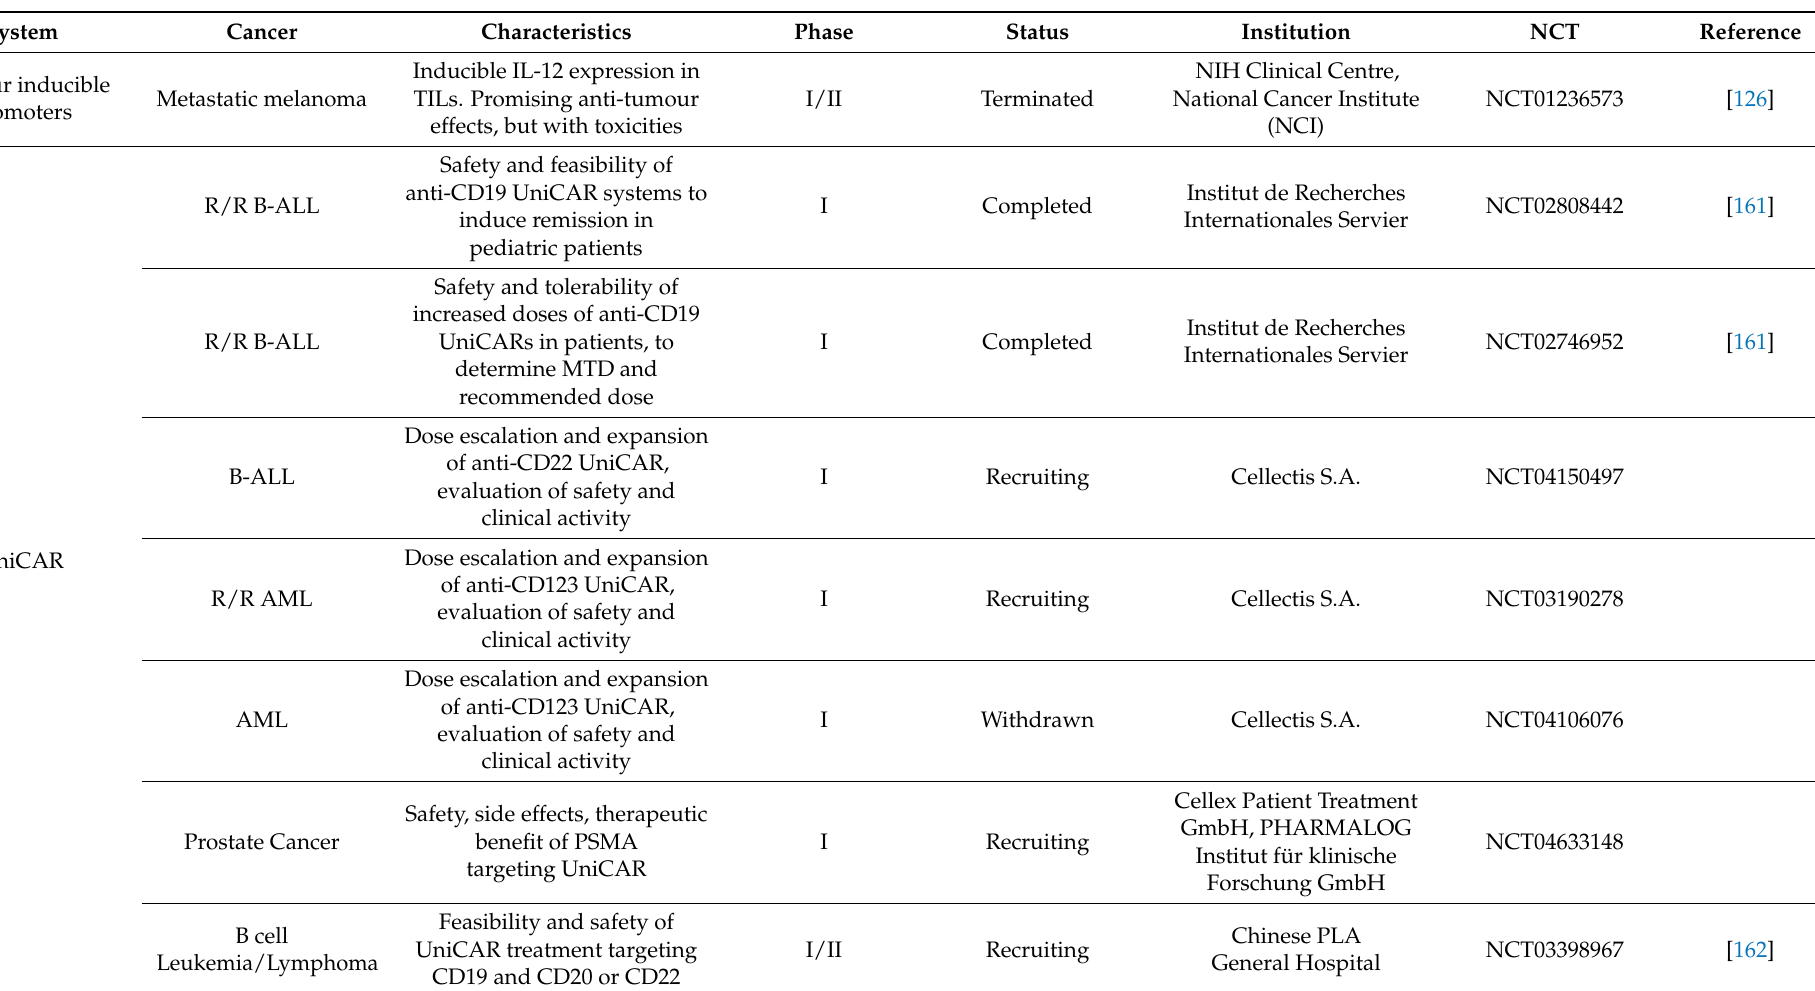
Table 1. Clinical trials utilising concepts with potential to enhance CAR T and NK cell infiltration of solid